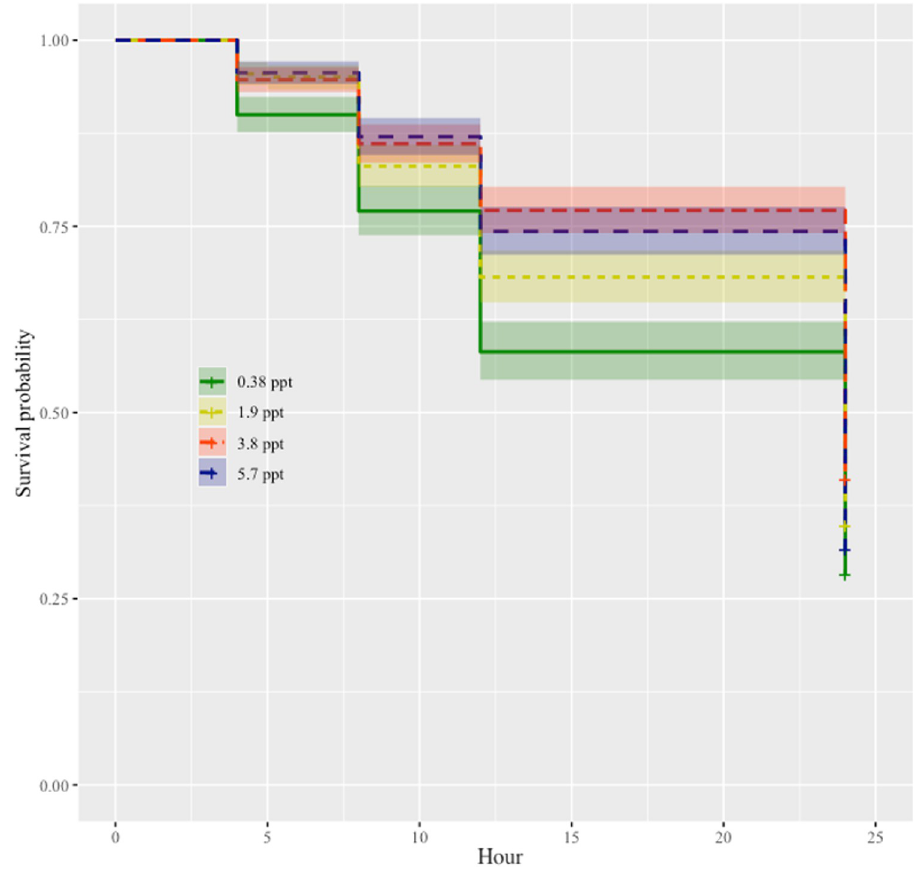
Fig 4. Survival probability of cercariae in 0.38 ppt, 1.9 ppt, 3.8 ppt, and 5.7 ppt salinity treatments over a 24-hour period. All four treatment groups are significantly different from one another except for 1.9 ppt and 5.7 ppt (p > 0.05) For pairwise comparisons see supplement Table G in S1 Text